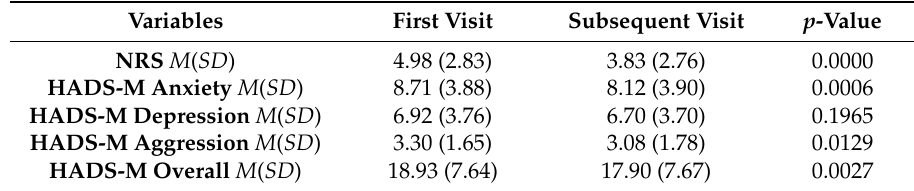
Table 2. Analysis of the effectiveness of treatment in pain